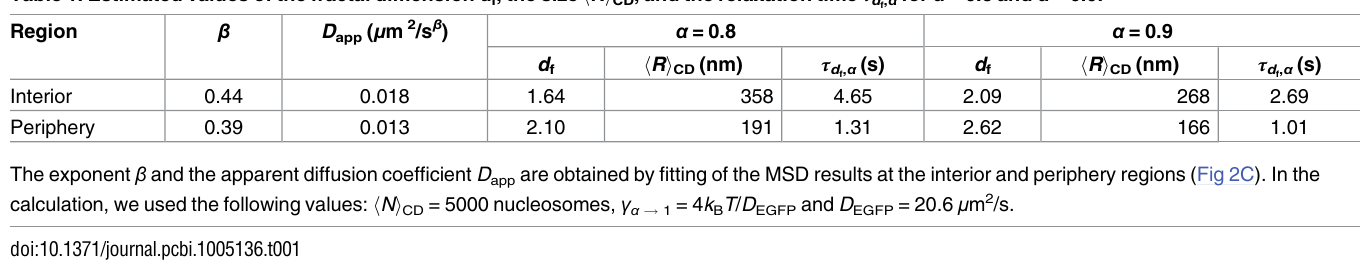
for α = 0.8 and α = 0.9. f , α